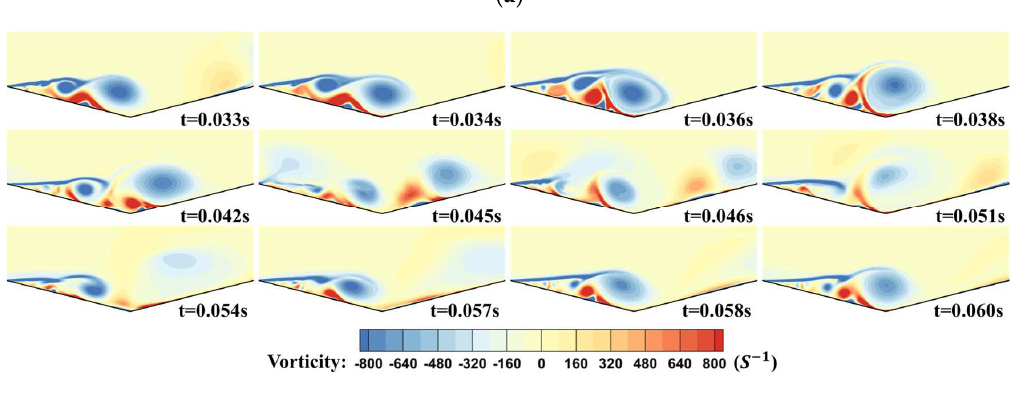
Figure 18. The vorticity contours of boundary vortices within grooves with ( a ) AR = 0.5, ( b ) AR = 8 at Re = 5.44 × 10 4